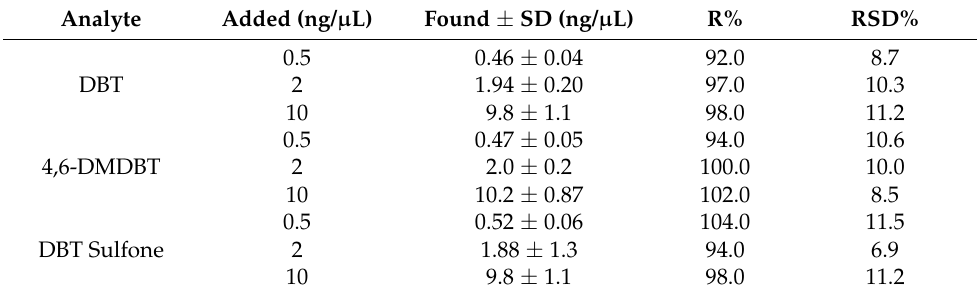
Table 3. Accuracy and between-day precision using CH 3 CN-H 2 O 90:10 v/v as mobile phase (du- plicate analyses in four days) .